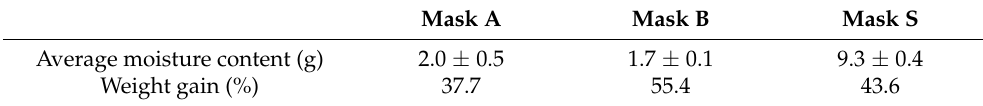
Table 3. Amount of moisture in the mask at the end of the